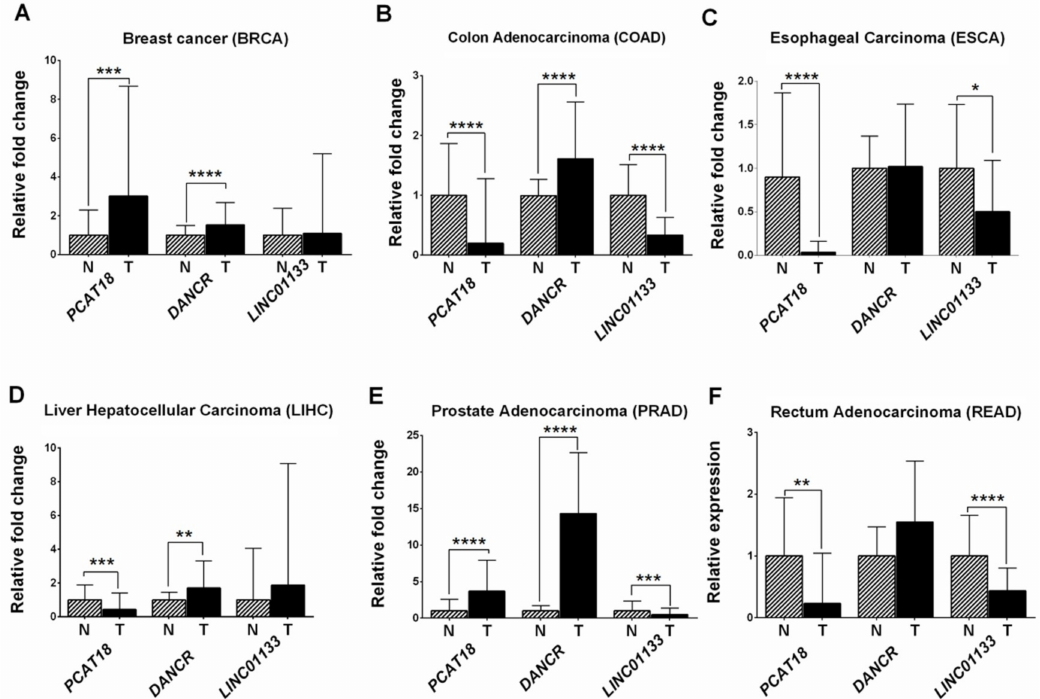
Figure 4. Expression levels of PCAT18 , DANCR , and LINC01133 in various tumor entities and their adjacent normal tissues. ( A ) Breast cancer (BRCA); ( B ) colon adenocarcinoma (COAD); ( C ) esophageal carcinoma (ESCA); ( D ) liver hepatocellular carcinoma (LIHC); ( E ) prostate adenocarcinoma (PRAD); and ( F ) rectum adenocarcinoma (READ). Expression data were retrieved from TCGA. * p ≤ 0.05, ** p ≤ 0.01, *** p ≤ 0.001, **** p ≤